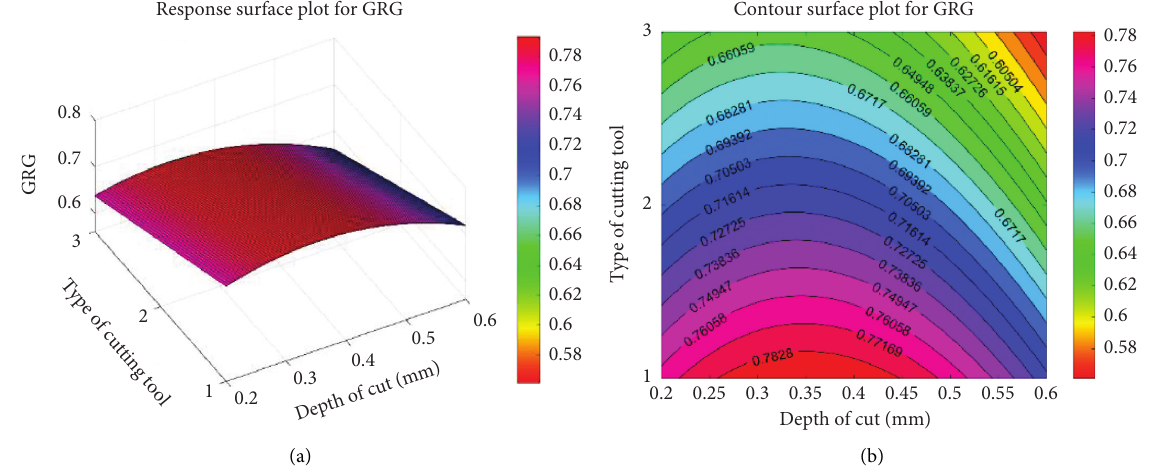
Figure 17: (a) Response surface plot for GRG (depth of cut vs. type of cutting tool). (b) Contour surface plot for GRG (depth of cut vs. type of cutting tool).